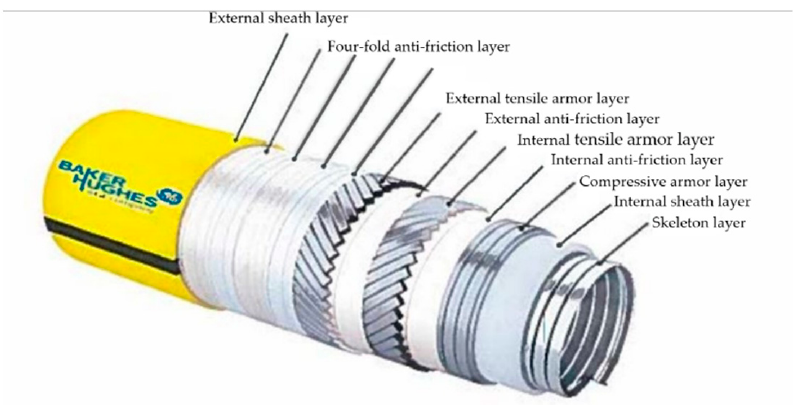
Figure 3. A schematic diagram of the multilayer flexible riser structure. The basic parameters of the riser are as Table